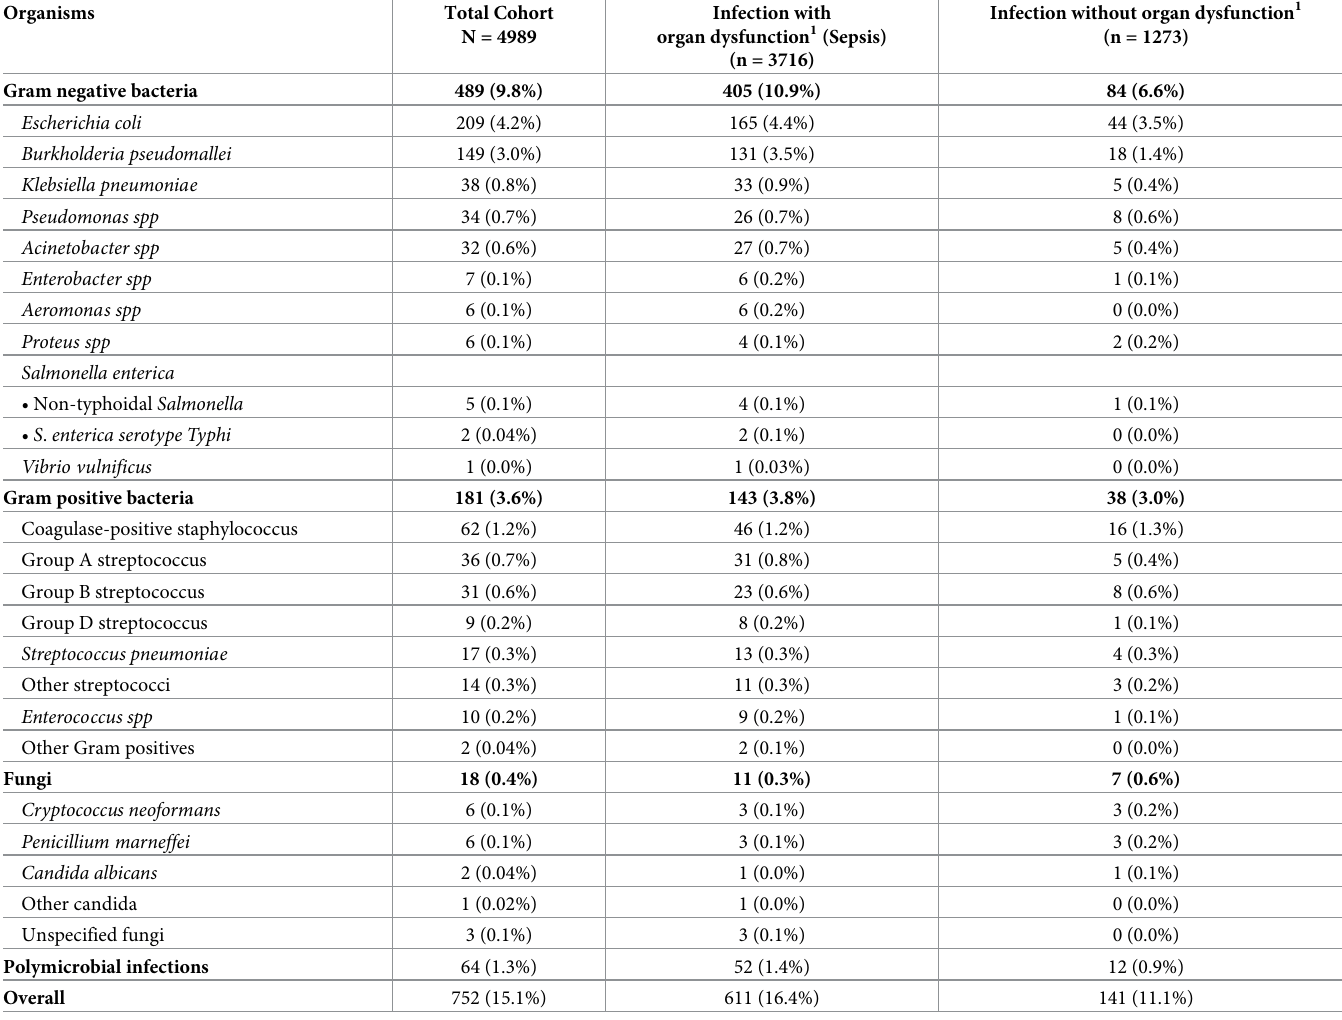
Table 2. Pathogenic organisms from 4,989 patients isolated within 24 hours of